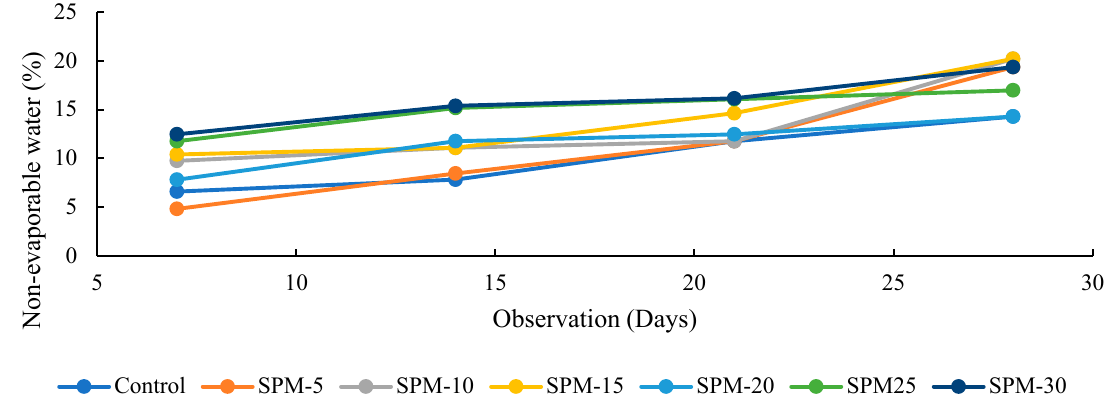
Figure 8. Nonevaporable water (Wn) of SP-based mortars.